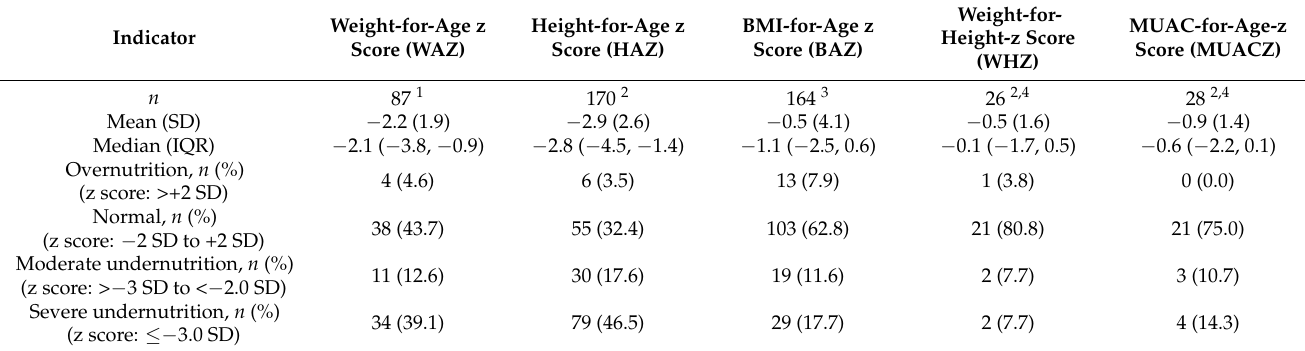
Table 1. Overall nutritional status of children registered into the Nepal CP Register